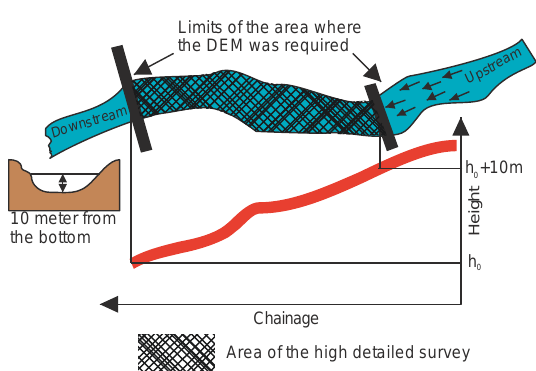
Figure 3. Definition of the boundary limits for the two areas where high detailed survey was required, the longitudinal profile of the riverbed is indicated in red Figure 4. Root Mean Square (RMS) accuracy of GNSS Precise Point Positioning solution vs windows time observation